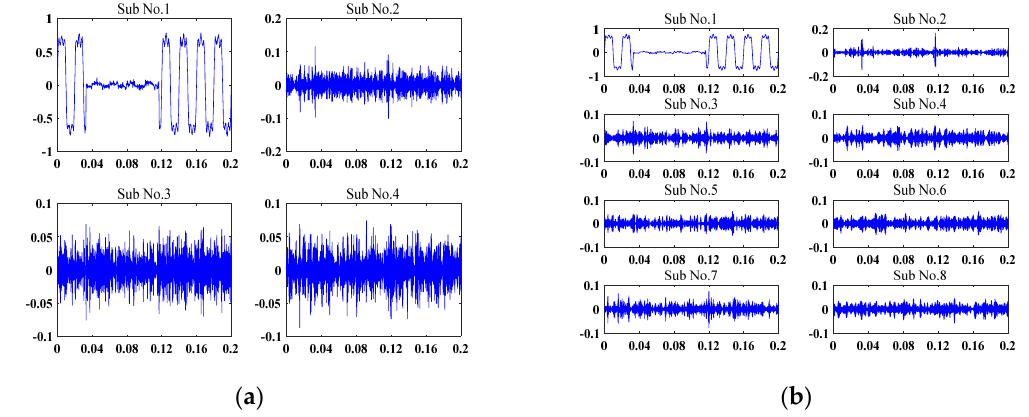
Figure 8. PQD signal decomposition results by WPD. ( a ) When the decomposition level is 2 by WPD; and, ( b ) when the decomposition level is 3 by WPD.